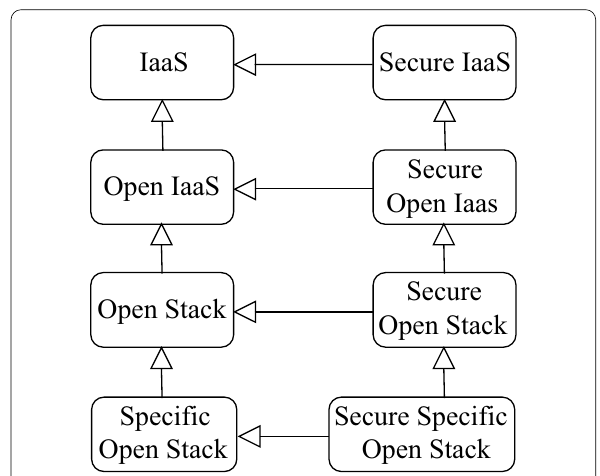
Fig. 12 Deriving secure IaaS